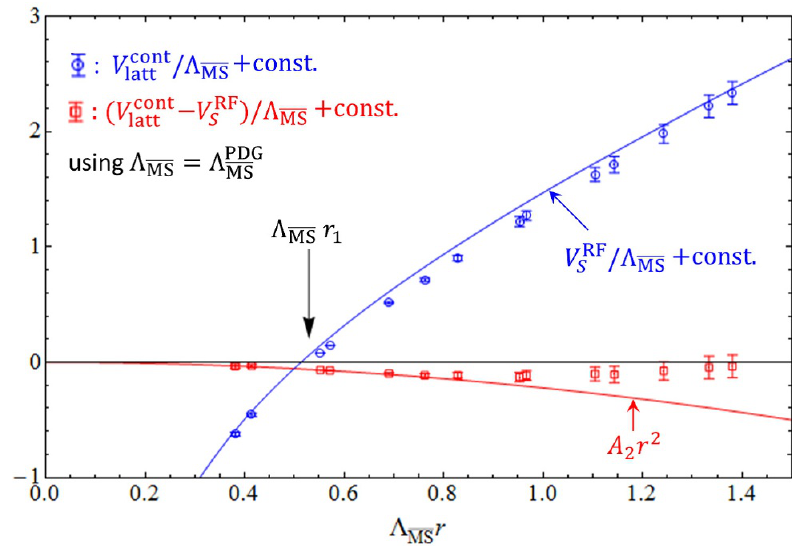
Figure 8 . Comparison of the lattice result (cont. limit: blue circles) and leading OPE prediction ( V RF = (cid:3) : blue line) using (cid:3) PDG and adjusting r -independent part. The di(cid:11)erence (red boxes) is S MS MS (cid:12)tted by const. (cid:2) r 2 (red line) at small r . is almost unchanged even if we adopt the (cid:12)rst 3 points in the (cid:12)t, although we use the (cid:12)rst 6 points in drawing the